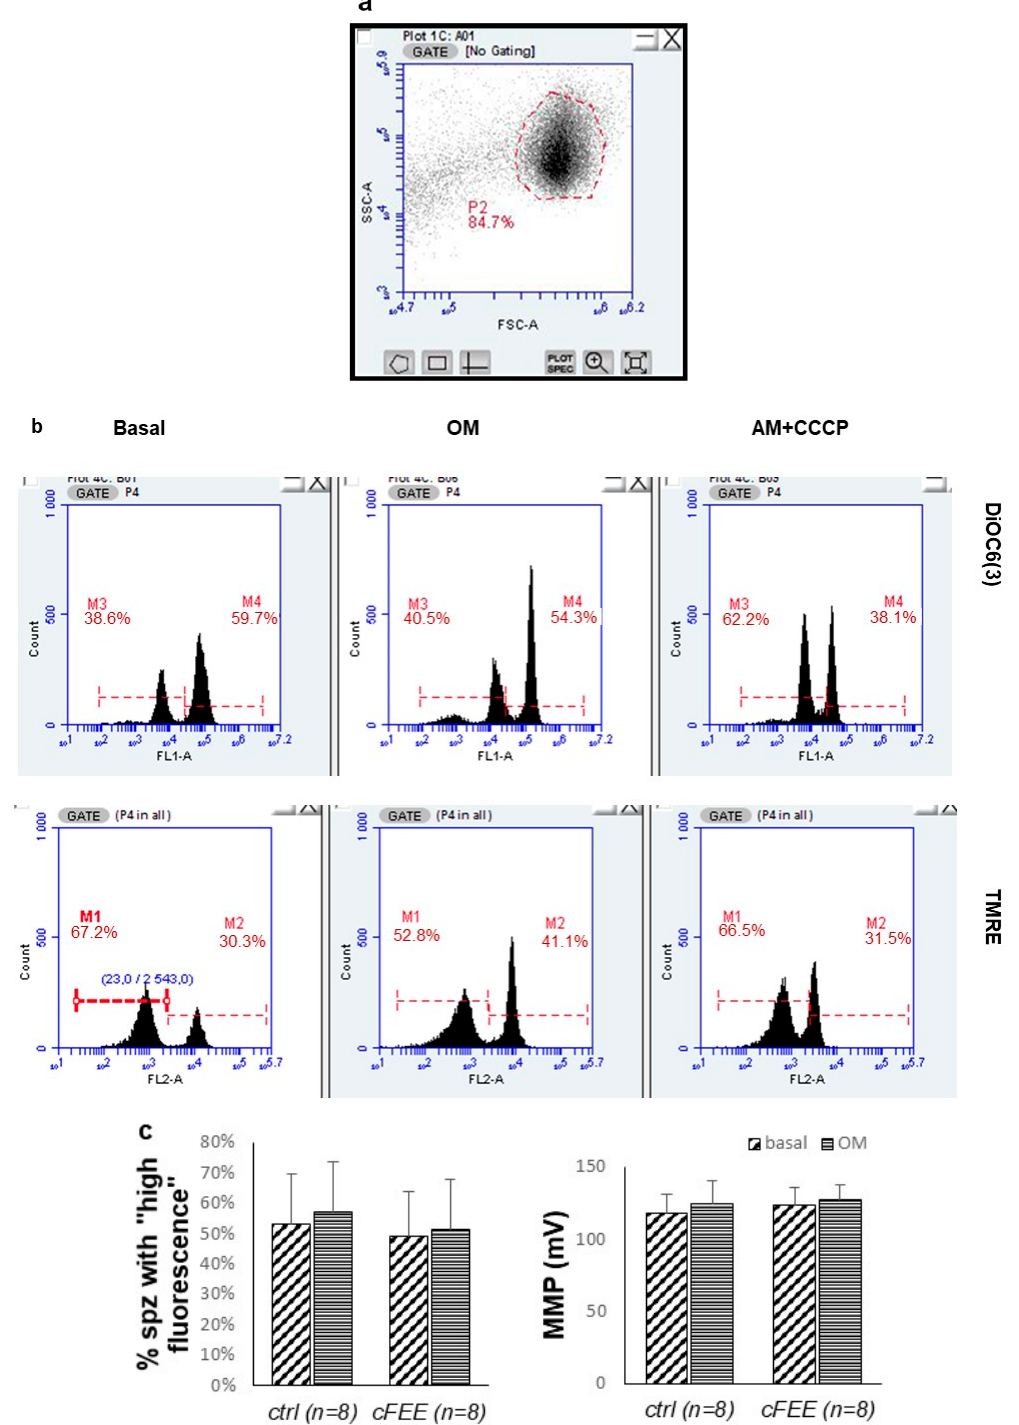
Figure 4. cFEE impact on mitochondrial membrane potential as measured by flow cytometry. ( a ). Spermatozoa were easily gated based on the size (FSC = forward scatter) and granularity (SSC = side scatter). ( b ) Two populations differing by their fluorescence signal were observed with both DiOC6(3) and TMRE probes, only the population with high fluorescence responded to the modulation of MMP, either increasing its signal upon ATP synthase inhibition by oligomycin (OM) or decreasing it upon MMP dissipation by the association of antimycin and CCCP (AM + CCCP). ( c ) cFEE had no impact on the proportion of spermatozoa with high fluorescence nor on their MMP calculated with the Nernst equation. To address the nature of the “low MMP” population, we used flow cytometry cou ‐ pled with fluorescence imaging contrast (ImageStreamX MKII ‐ AMNIS Corp., Seattle, WA, USA) and staining with 100 nM TMRE (Figure 5). The method uses the initial selec ‐ tion of the objects of interest based on their morphology in bright field. In our case, suc ‐ cessive use of algorithms, tight function mask then twice dilated binary filter, allowed for the recognition of all objects (sperm, smaller debris, calibration beads…) that appear high ‐ lighted by blue masks (Figure 5a). Ordering these objects by size and number per field allows the selection of the objects that are both lonely with a surface above 75 pixels. Vis ‐ ual inspection confirmed that the selected population contained only spermatozoa. They represented roughly 10% of the initial objects. The fluorescence signal of the sperm pop ‐ ulation was then analyzed as in regular cytometry, but with the possibility to individually visualize each object whose fluorescence was recorded (Figure 5b). The proportion of spermatozoa with very low fluorescence was roughly 50%; this was similar after sperm selection using a double (45–90%) or a triple Pursperm gradient (45–65–90%) procedure. Transfer to the two control situations (oligomycin or antimycin + CCCP inhibition) of the positive and negative peaks, defined in the basal state, allowed for calculating the propor ‐ tion of fluorescent sperm (# sperm in positive peak/total # sperm analyzed) and MMP (according to Nernst law, taking as zero signals the fluorescence value under antimycin + CCCP inhibition). With this technique, we analyzed seven independent sperm preparations after a 3 ‐ h incubation with or without cFEE. Although the MMP under oligomycin inhibition was globally higher than in the basal state ( p = 0.003 with the paired t Student test on the 28 pairs of data), this difference did not reach significance in the smaller groups of seven pairs of data (Figure 5d). cFEE had no significant impact on the MMP nor on the propor ‐ tion of the sperm belonging to the positive peak, either in the basal state or under oligo ‐ mycin inhibition (Figure 5e).